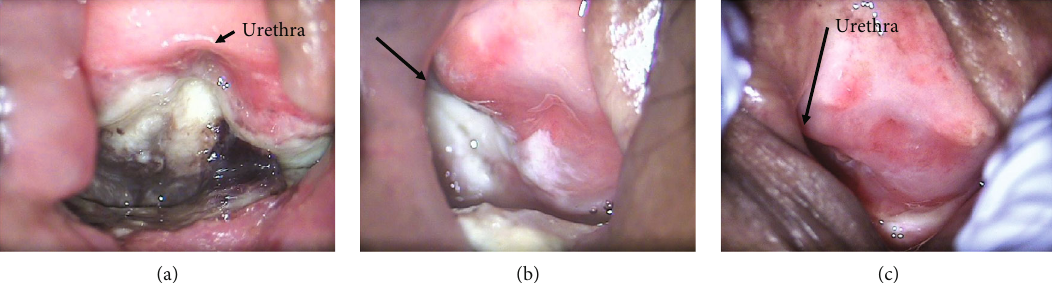
Figure 1: (a) A necrotic penetrating mucosa was observed in the suburethral vaginal wall. (b) The necrotic mucosa closed partially after 30 hyperbaric oxygen therapy (HBOT) sessions. (c) The necrotic mucosa was completely replaced by the normal mucosa after 60 HBOT